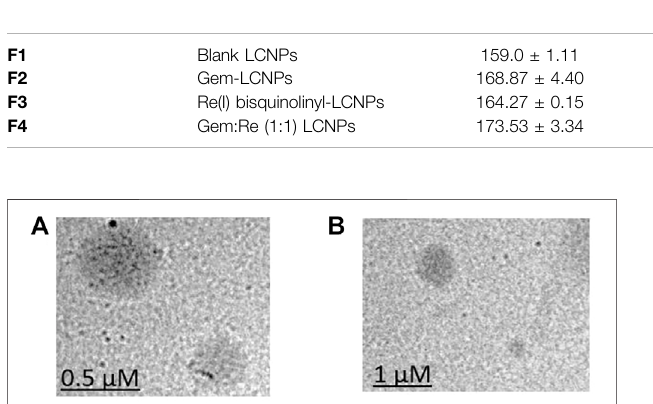
TABLE 4 | CharacterizationsofBlankLCNPs,Re(I) bisquinolinyl-LCNPs, Gem-LCNPs, and Gem:Re-loaded (1:1)LCNPs featuring thecomposition, size, PDI, zetapotential, and entrapment ef fi ciency (EE) (n = 3). Formulation